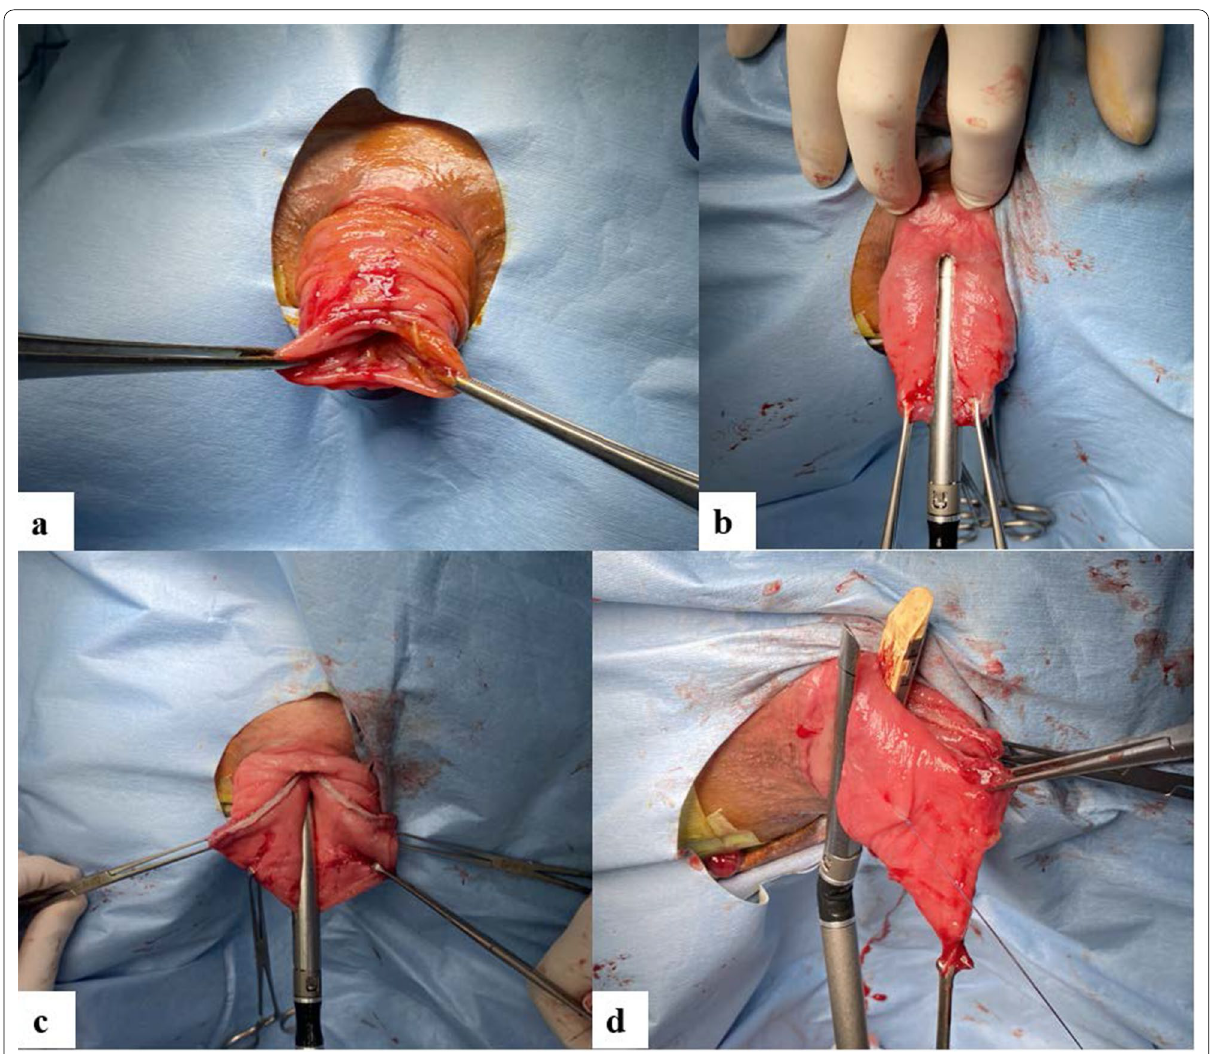
Fig. 1 a A 5-cm prolapse of the rectum. b The prolapse of posterior wall was cut along the long-axis direction. c The prolapse of anterior wall was cut along the long-axis direction. d The prolapse was resected along the short-axis direction with four linear staplers